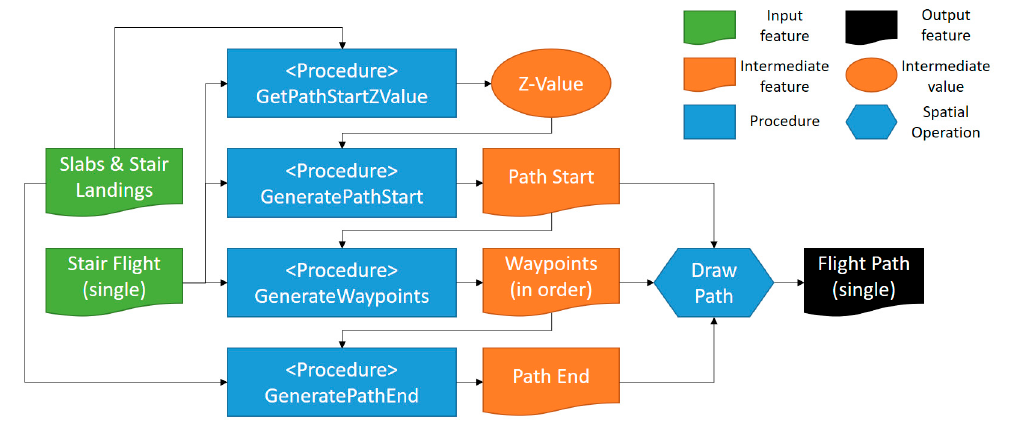
Figure 11. Flowchart for generating a stair flight path.